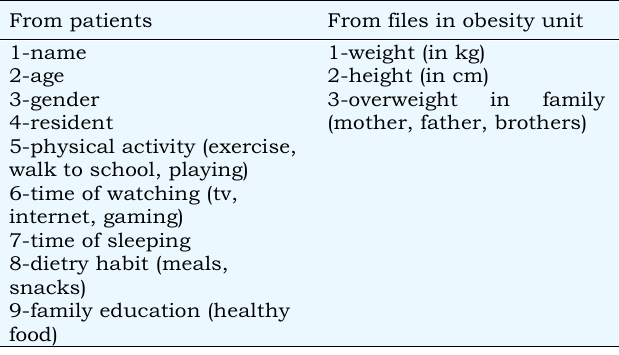
Table 1 Variables used in the questionnaire